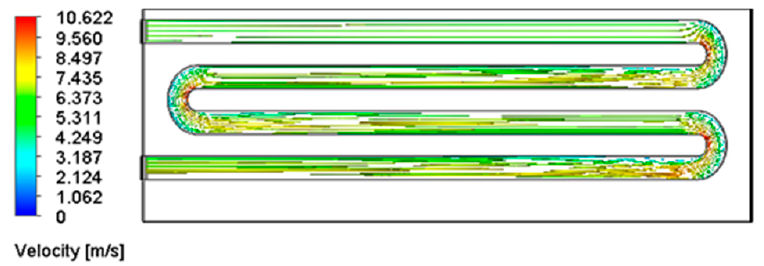
Figure 10. Graph of flow rate simulation results.